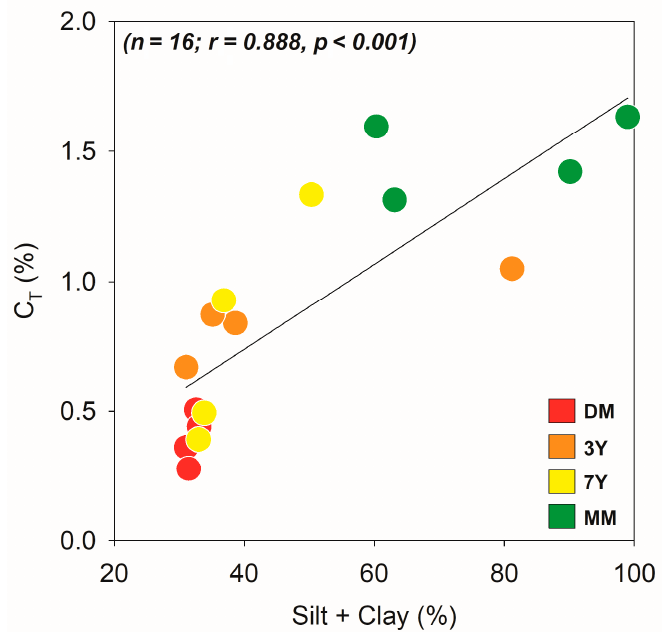
Figure 5. Spearman correlation between fine particles (i.e., silt + clay) and soil total organic carbon content (C T ) for the studied areas. DM: degraded mangrove, 3Y: mangroves with 3 years of planting, 7Y: mangroves with 7 years of planting, MM: mature mangrove forest, p values < 0.05 indicate significant correlation.